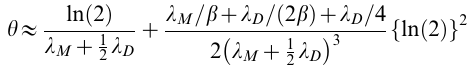
[ PIN + ] and YJW679 [ PSI + ] [ pin 2 ] and their [ psi 2 ] derivatives. Cell Type